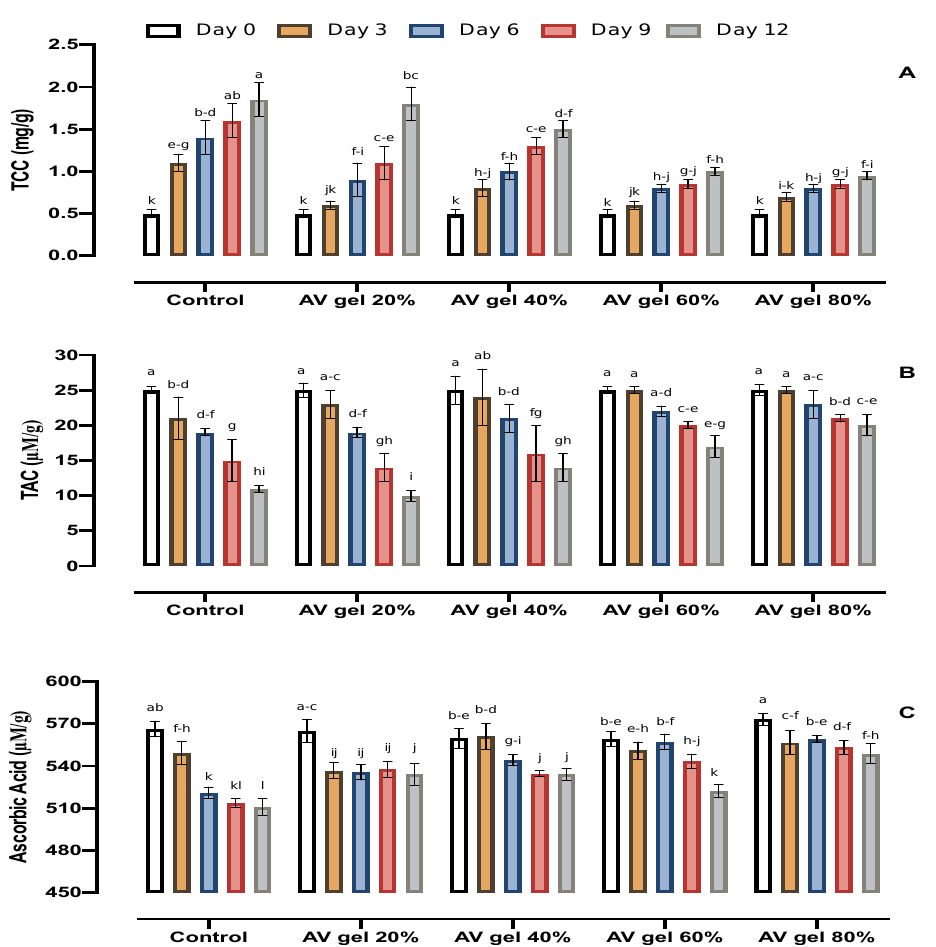
Figure 5. Effects of AV gel coating on total carotenoids ( A ), total antioxidant capacity (TAC) ( B ), and ascorbic acid ( C ) in guava fruit. Standard error shown by vertical bars; each value is the mean of three replicates. Different letters on the top of the bars indicate significant differences ( p ≤ 0.05).